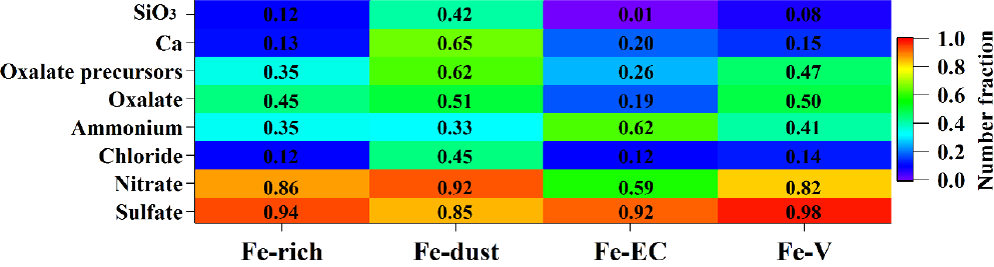
Figure 6. The number fractions of sulfate ( m/z − 97), nitrate ( m/z − 46 or − 62), chloride ( m/z − 35 or − 37), ammonium ( m/z 18), oxalate ( m/z − 89), oxalate precursors ( m/z − 59 , − 71, − 73, − 87, 103, or − 117), Ca ( m/z 40), and [ SiO 3 ] − ( m/z -76) in the four Fe-containing cloud